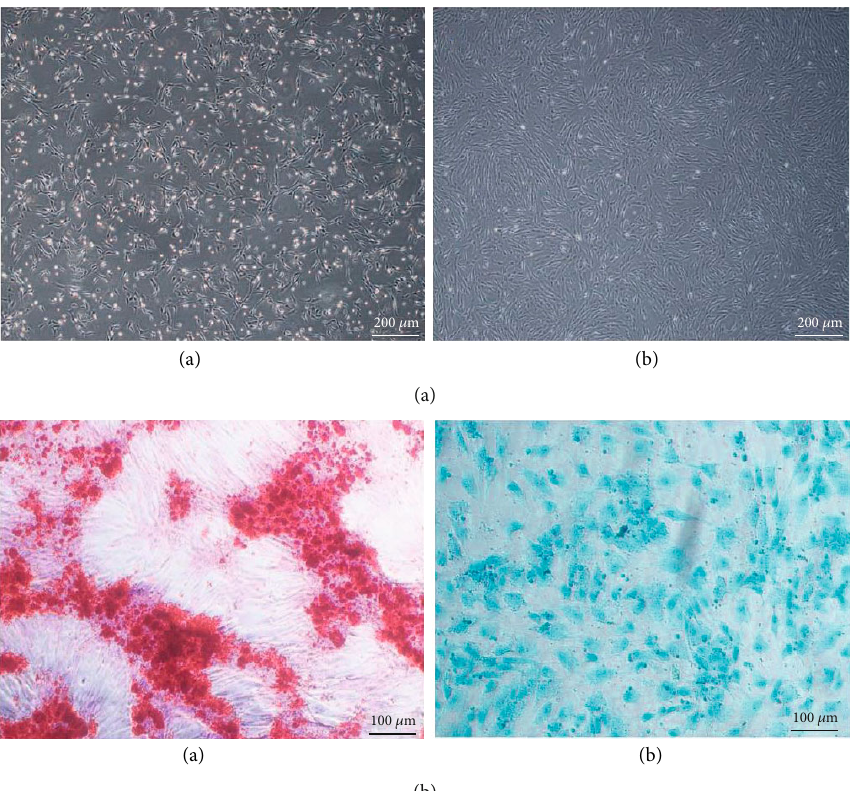
Figure 3: (a) Microscopic observations of hAMSCs. (A) P0 hAMSCs. (B) P3 hAMSCs. Scale bar: 200 μ m. (b) Multidirectional di ff erentiation potential for osteogenic and chondrogenic di ff erentiation of passage 3 hAMSCs. (A) Osteogenic di ff erentiation (alzarin red staining). (B) Chondrogenic di ff erentiation (alcian blue staining). Scale bar: 100 μ